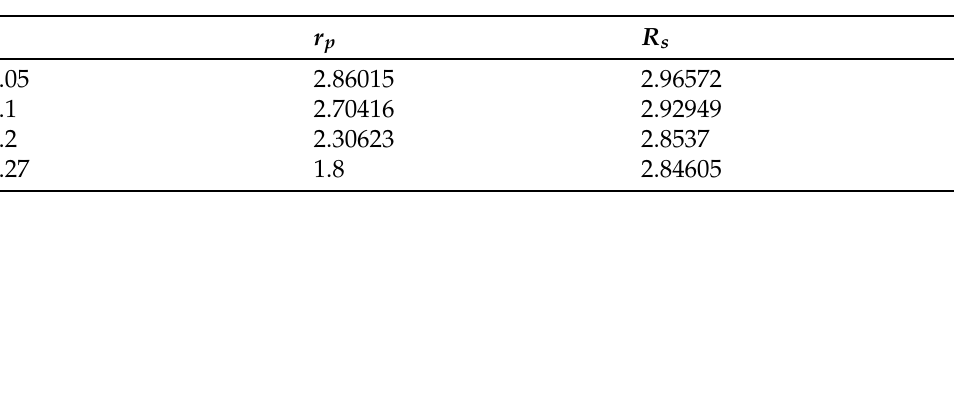
Table 1. Effects of the tidal charge on the BH shadow for fixed M p = 1, M 5 = 0.5, M =